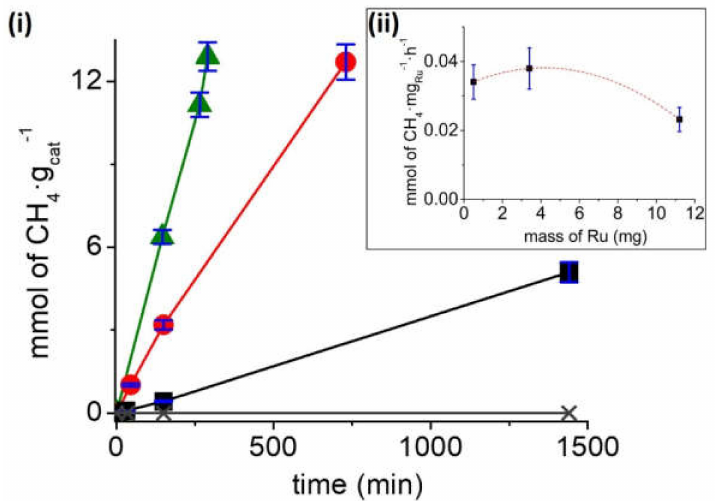
Figure 5. ( i ) Photothermal catalytic hydrogenation of CO 2 to methane at 180 ◦ C and 150 mW / cm 2 light power in the presence of Ru / TiNT samples with di ff erent Ru content. Na,H / TiNT ( × ), Ru / TiNT-0.5 ( (cid:4) ), Ru / TiNT-3.5 ( • ), and Ru / TiNT-11 ( (cid:78) ). ( ii ) Production rate per mg of Ru deposited on the